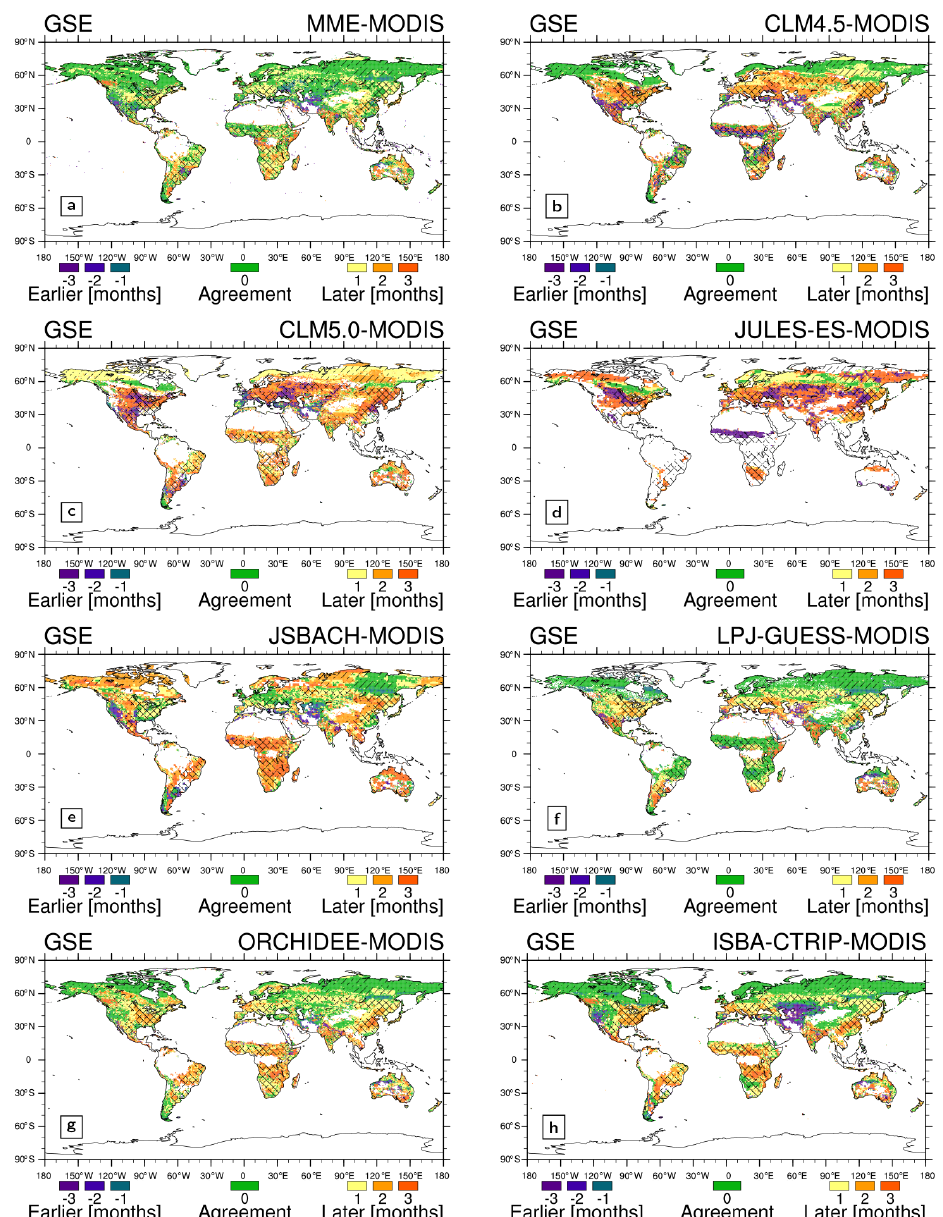
Figure 5. As Fig. 4 but for growing season end (GSE) timings. Note that the GSE in the TGS regions corresponds to the GSE of the second growing season